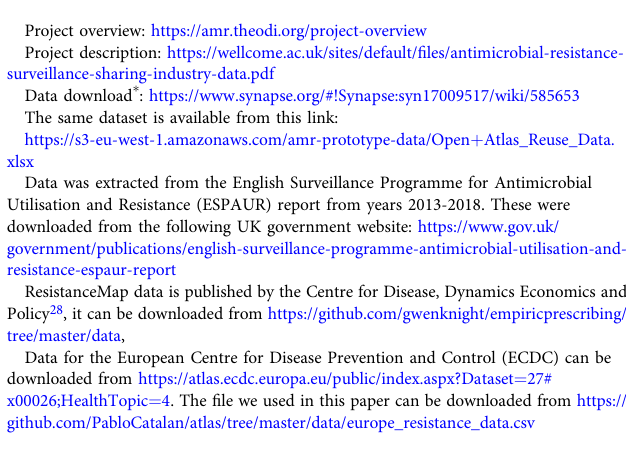
Fig. 8 Testing ATLAS for self-consistency by comparing TEST and INFORM predictions separately. A Positive (red) and negative (blue) R-MIC changes for all pathogen-antibiotic (PA) pairs in the TEST sub-component of ATLAS were predicted by regressing R-MIC versus time (as Fig. 6B). B Predicted positive (red) and negative (blue) R-MIC changes for all PA pairs in the INFORM sub-component of ATLAS. C The difference between R-MIC dynamics in TEST and INFORM for those PA pairs that appear in both datasets; the 3 antibiotics with the largest absolute changes are indicated with arrows. D Percentage differences between the frequencies of resistance observed in TEST and INFORM for all PA pairs and all years for which data is available. Although some differences are large (as much as 100%) note how the between-database differences decline with increasing numbers of